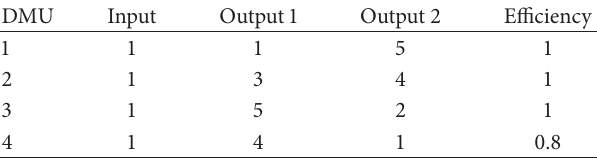
Table 4: The data of Example